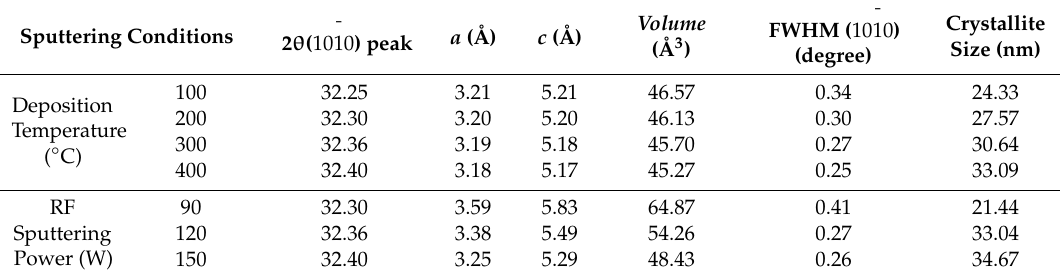
Figure 2. ( a , b , d ) SEM surface images and ( e – g ) 3D AFM morphologies of Ge 0.07 GaN films deposited at ( a,d ) 90 W, ( b , e ) 120 W, and ( c,f ) 150 W in Ar / N 2 atmosphere. The insets present their single cross-sectional images. Table 3. Structure properties of Ge 0.07 GaN thin films at different sputtering powers and substrate temperature from X-ray diffraction analyses.